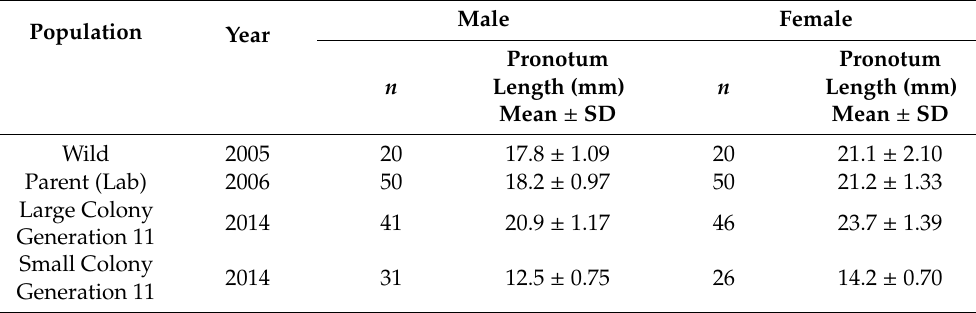
Table 1. Change in mean pronotum length of Romalea microptera grasshoppers during 8 years (11 generations) of artificial selection in the laboratory for either long- or short-pronotum length. See Section 2 for description of selection experiment and